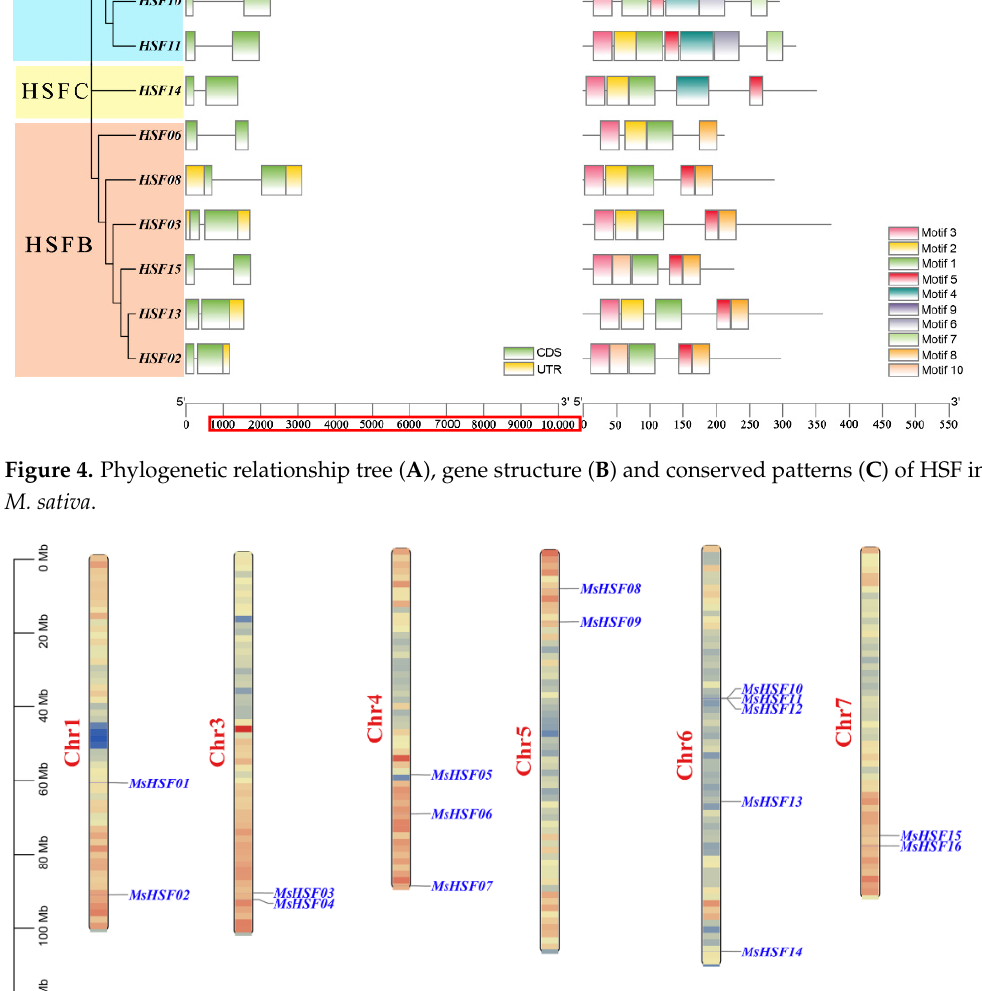
Figure 6. Chromosome distribution and interchromosomal relationships of MsHSF genes. Gray lines indicate synthetic blocks within the M. sativa genome, and red lines indicate duplicated MsHSF gene pairs. Additionally, the proportion of HSF genes shared by M. sativa and other species may reflect the evolutionary relationships of the HSF gene family among M. sativa , dicotyledons, and monocotyledons. Therefore, in this study, we constructed a comparative homozygous map of three HSF genes from M. sativa and three dicots ( A. thaliana , G. max , and Medicago truncatula ) and one monocot ( Z. mays ) (Figure 7). A total of 44 direct homologous pairs (in- cluding one M. sativa gene corresponding to more than one G. max gene) were studied